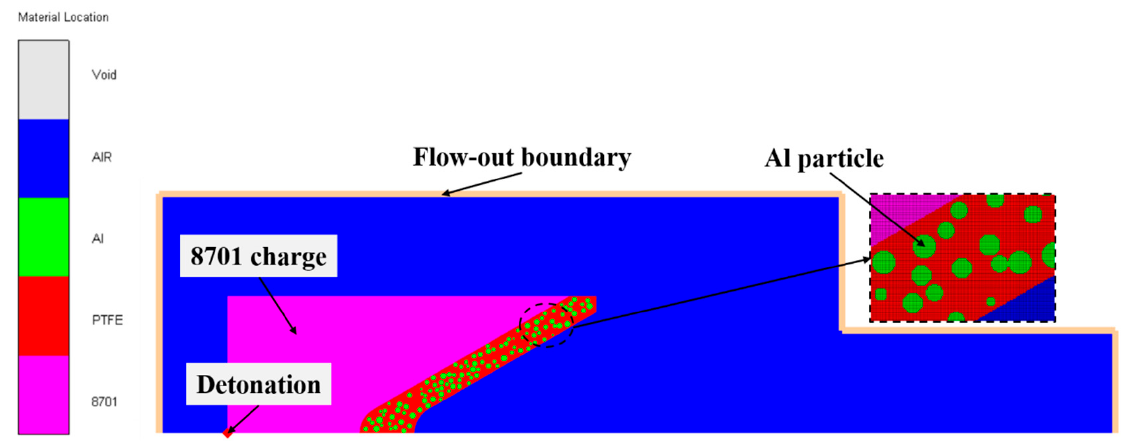
Figure 5. 2D finite element model of the PTFE/Al liner shaped charge.